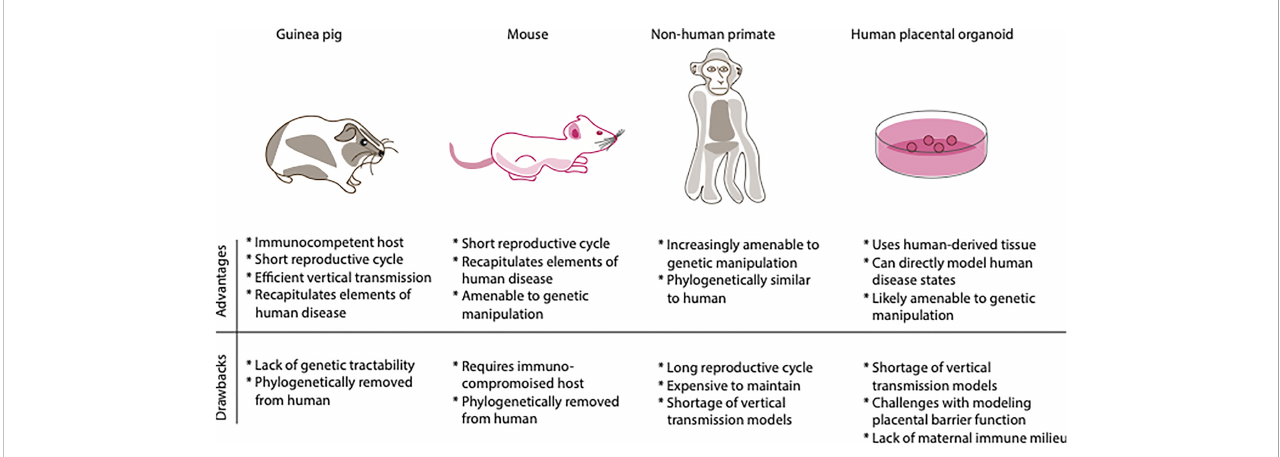
FIGURE 2 Comparison of relative advantages and drawbacks of various models of vertical transmission. Shown above are depictions of the different model systems of congenital infection. Shown below is a table of the relative advantages and drawbacks of each model system, emphasizing immune system, genetic tractability, life cycle, and